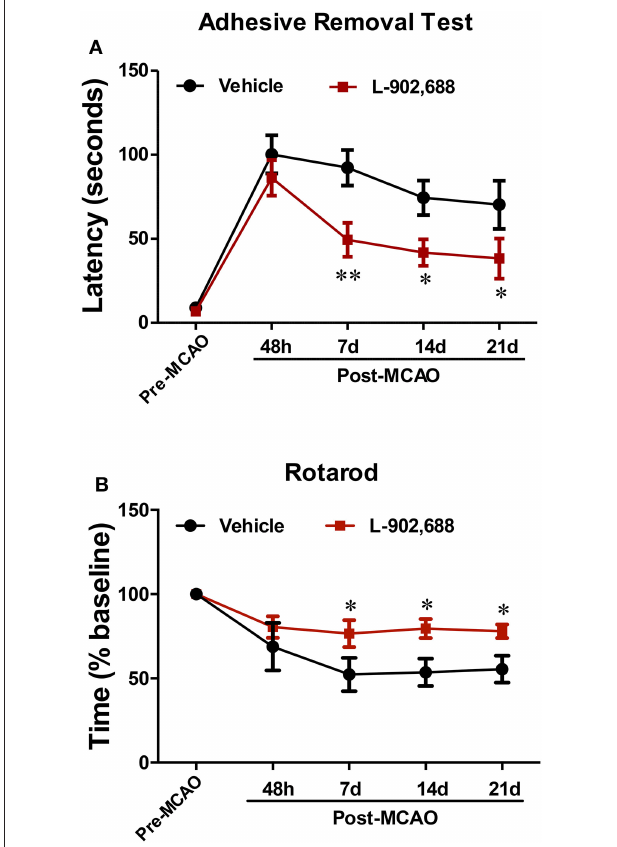
FIGURE 6 | Post-ischemic treatment with L-902,688 Reduces Stroke-Induced Neurological Deficits. (A) L-902,688 administration reduces the latency to contralateral adhesive removal in rats subjected to stroke. (** P < 0.01, * P < 0.05). (B) L-902,688 increases the time spent on the rotarod compared to vehicle-treated rats (* P < 0.05). Data analyzed with multiple t -tests; n = 10 in each treatment group.